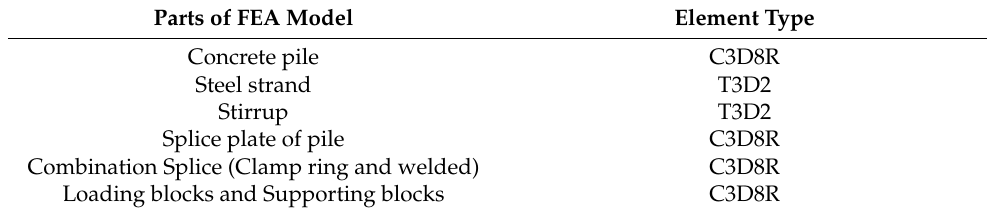
Table 9. Element type of FEA model.